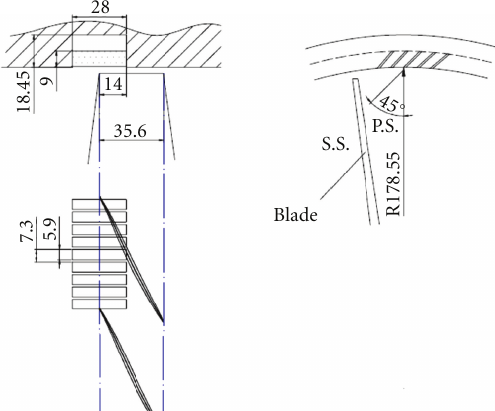
Figure 4: Sketch of the CBUAA slot-type casing treatment